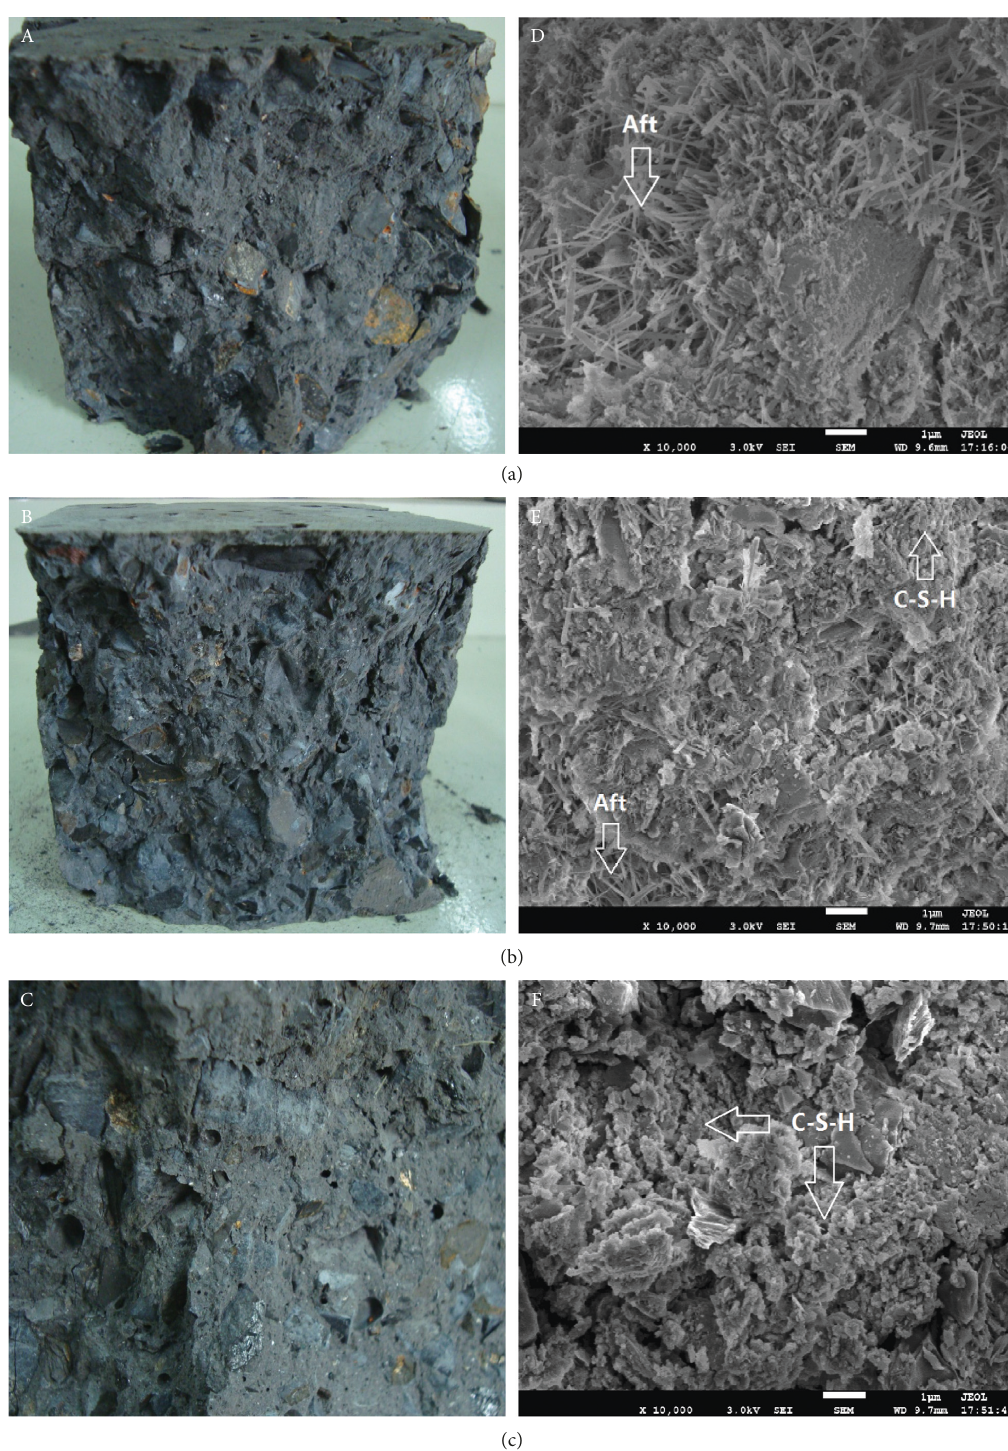
Figure 7: Damaged sections and SEM picture of (a) 0, (b) N3, and (c)